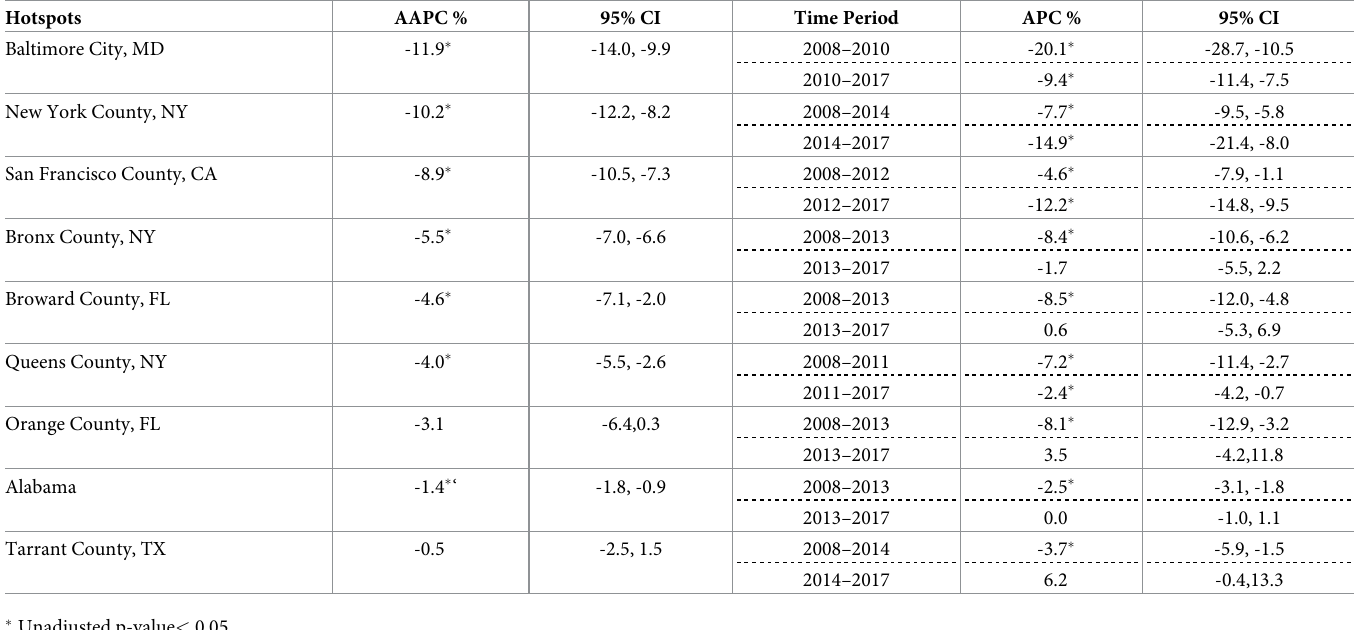
Table 2. Trends in US hotspots with significant changes in AAPC using Joinpoint regression analysis, 2008–2017. Hotspots